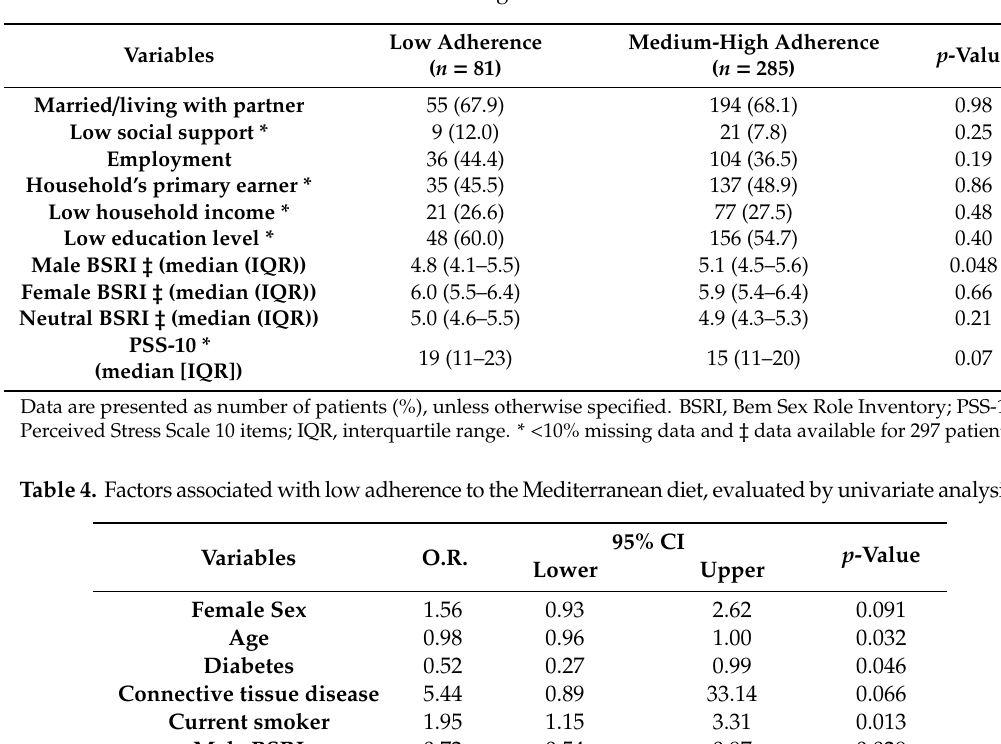
Table 3. Gender-related factors according to the adherence to the Mediterranean diet.